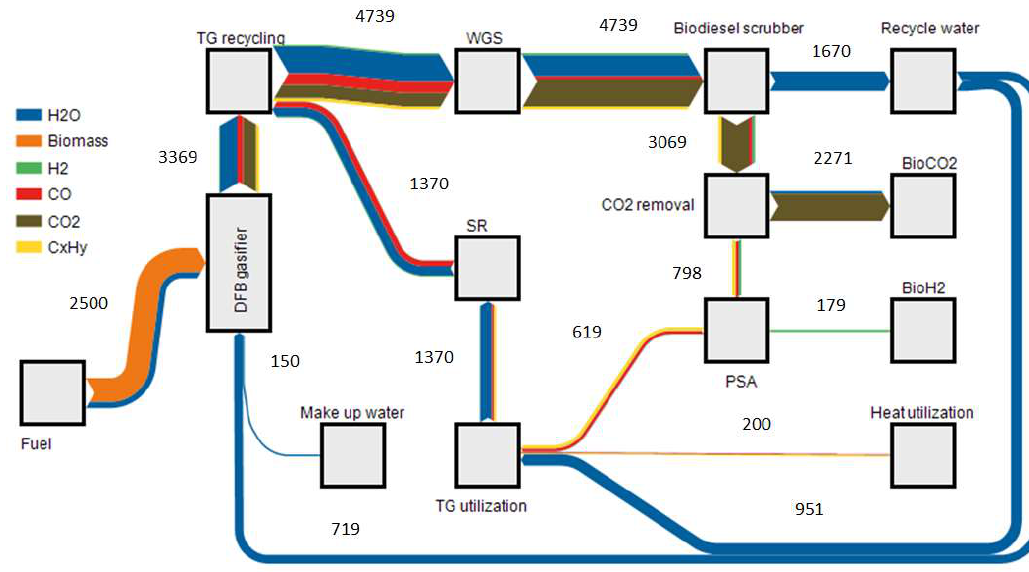
Figure 5. Sankey diagram of the mass balance for a 10 MW BioH 2 plant (flows in kg/h).